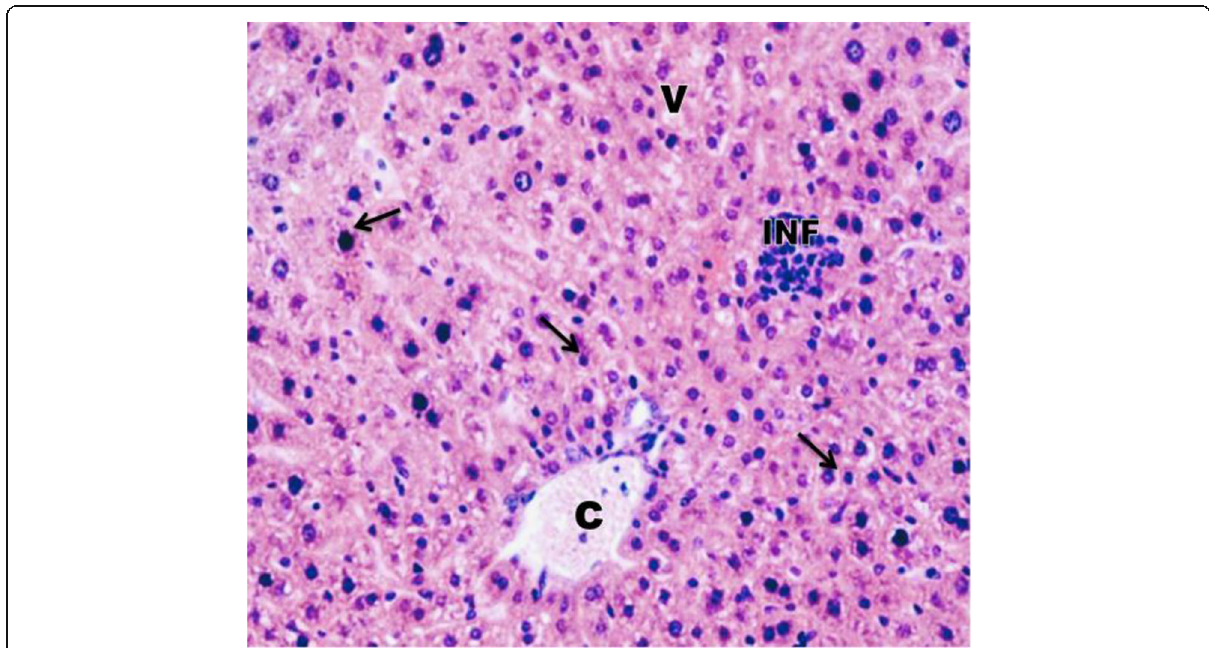
Fig. 8 Photomicrograph of a section of the liver of treated mouse with Adamine (20 mg/kg b.wt.) for 15 days showing vacuoles (V) in hepatocytes with pyknotic nuclei (arrows), inflammatory cells (INF), and congestion of central vein (C). (H&E, ×